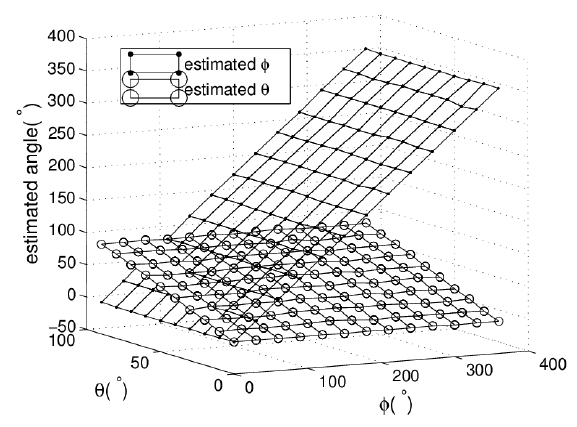
Figure 9. Estimated ϕ and θ on sample positions.